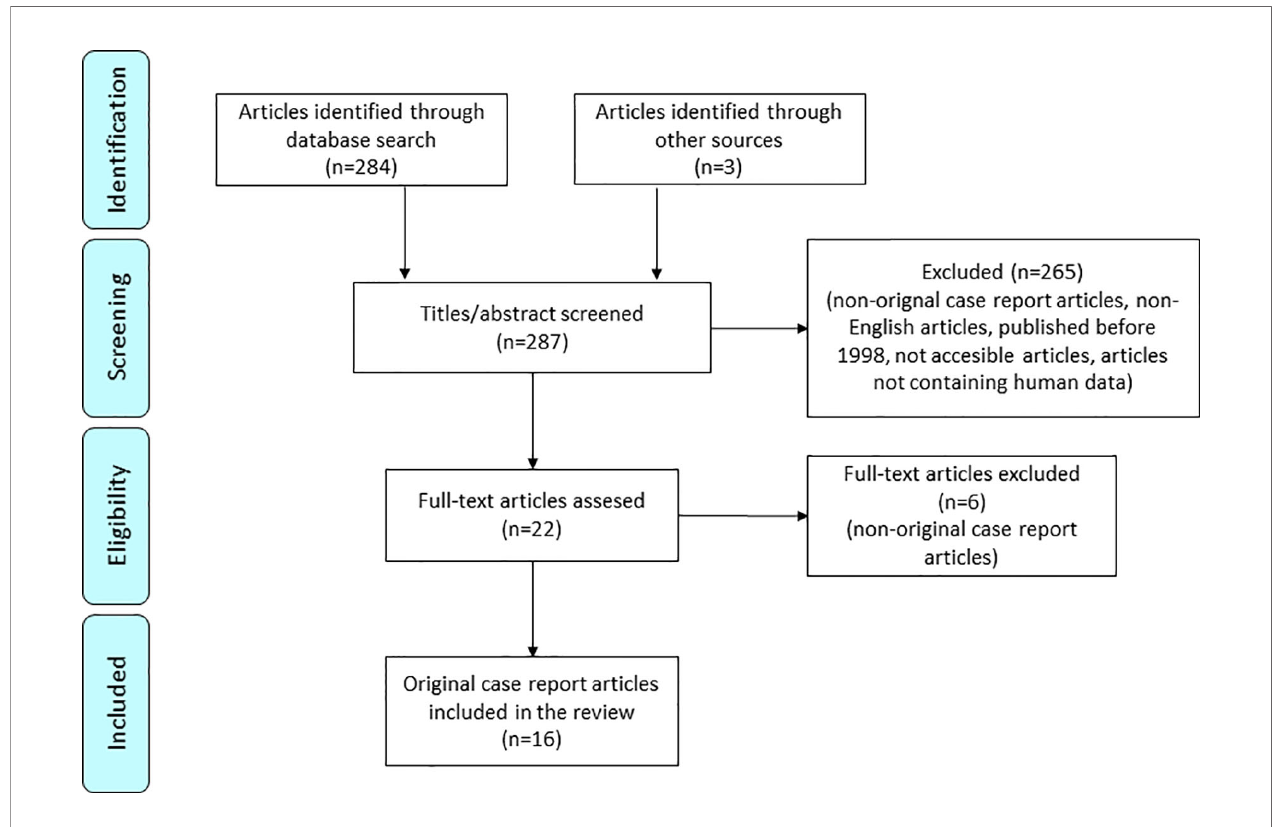
FIGURE 1 | PRISMA fl ow diagram for systematic case review of POMC de fi ciency